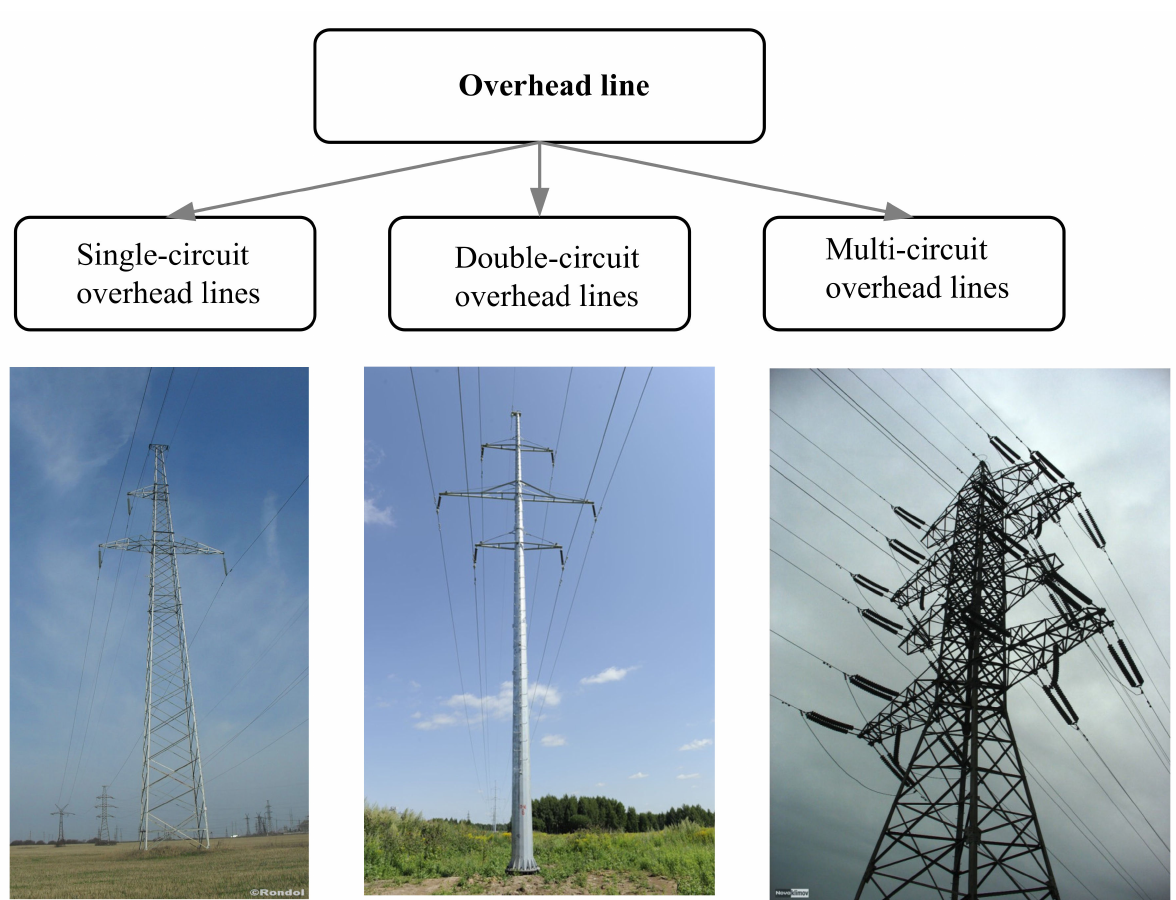
Figure 2. Classification of overhead power lines by number of